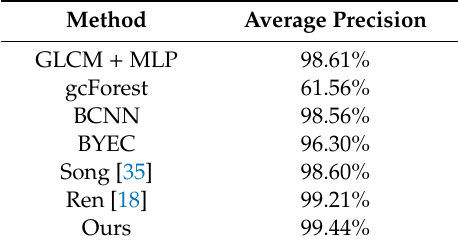
Table 2. Comparison of results on NEU surface defect dataset.